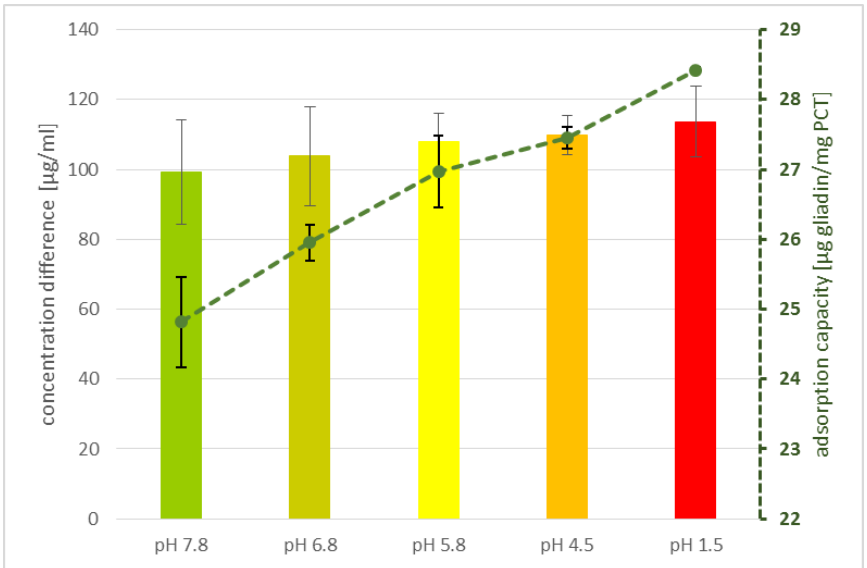
Figure 3. Adsorption of gliadin to PCT and corresponding adsorption capacity at varying pH. Different phosphate buffers (pH 4.5, 5.8, 6.8, and 7.8) and a test solution (pH 1.5) were used to determine the influence of pH in a binding experiment of gliadin (125 µ L/mL) onto PCT (0.1 g/mL). One representative experiment is shown. Bars indicate the difference in concentration of gliadin measured in the pure gliadin solution and the amount of gliadin after incubation with PCT at each tested pH value corresponding to the “concentration difference” in the axis label. Every single bar gives the specific binding potential of gliadin to PCT in µ g/mg. Standard deviations are shown. The dashed line relates to the calculated adsorption capacity.